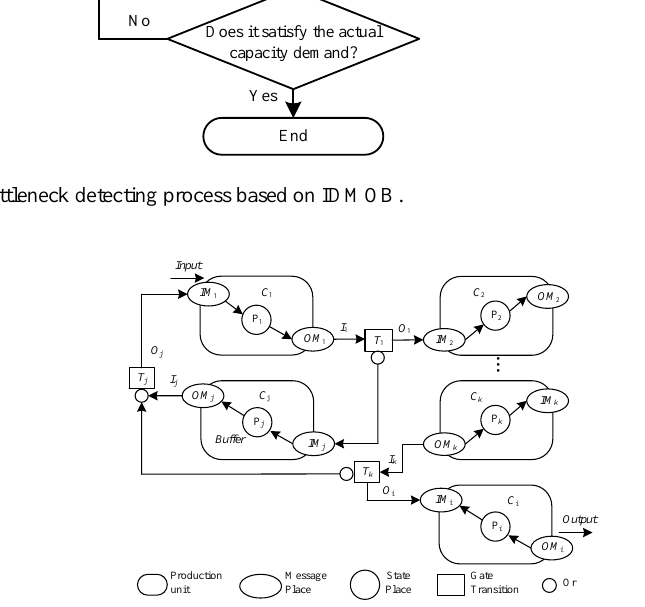
Fig. 2. Abstract model of IDMOB with